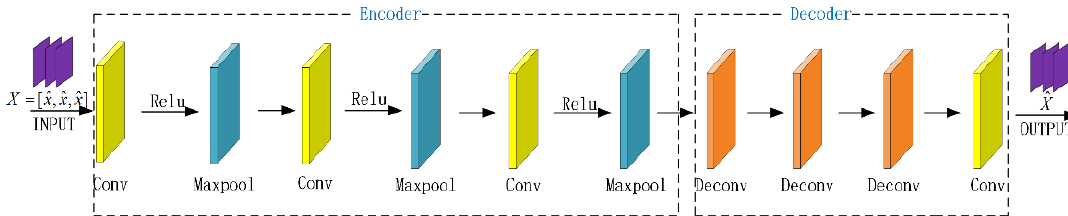
Figure 6. The structure of the denoising autoencoder.